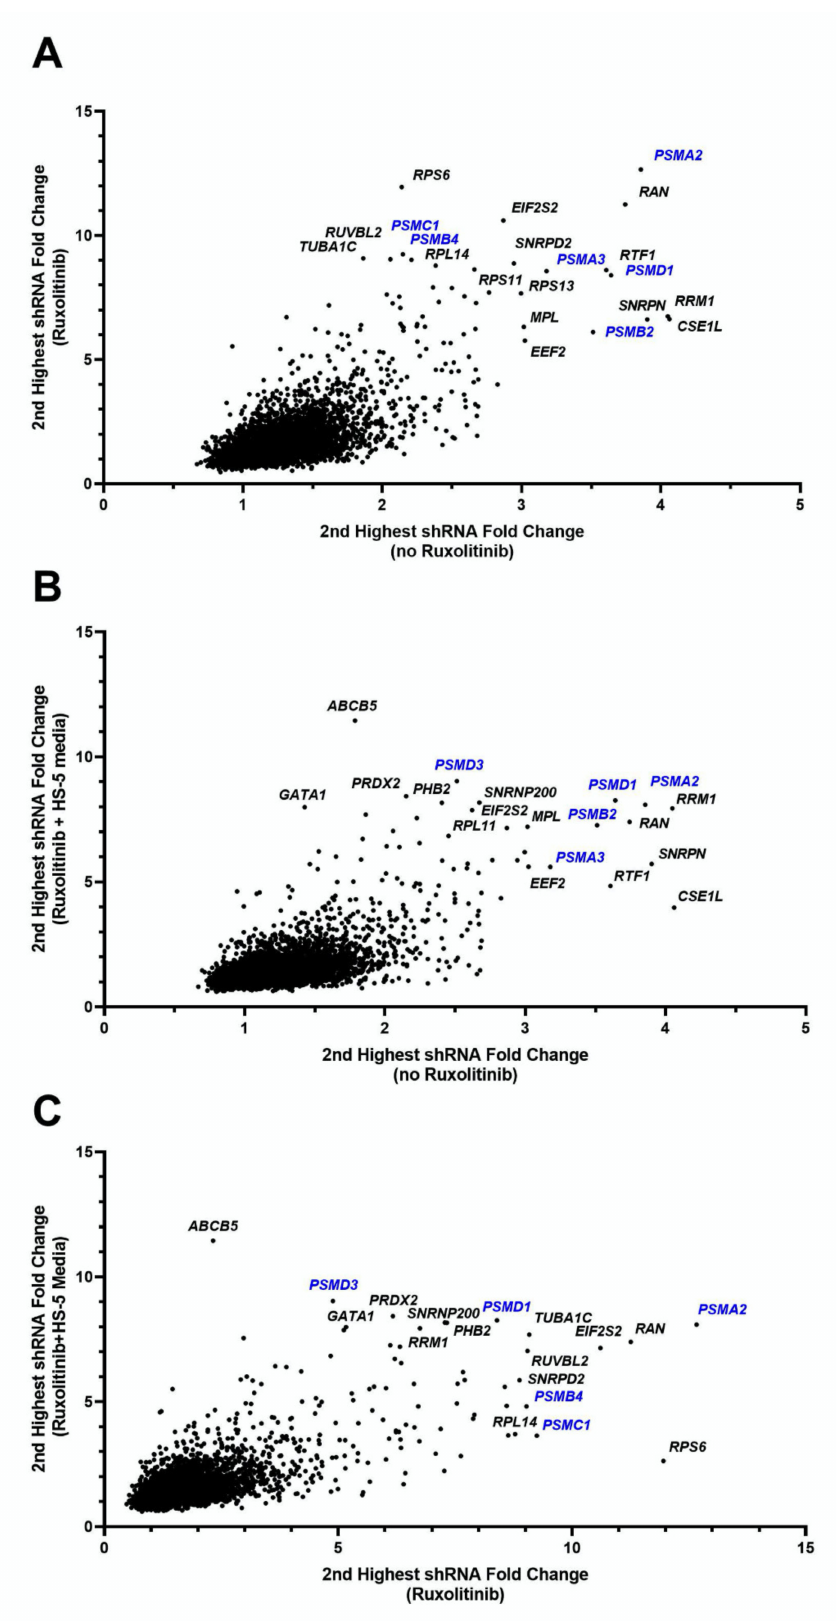
Figure 2. Fold change of shRNAs for HEL cell line under various conditions. Each figure shows the second highest fold change for shRNAs targeting each of 4974 genes, showing comparisons for each combination of conditions. Genes in the uppermost right corners indicate genes which under both